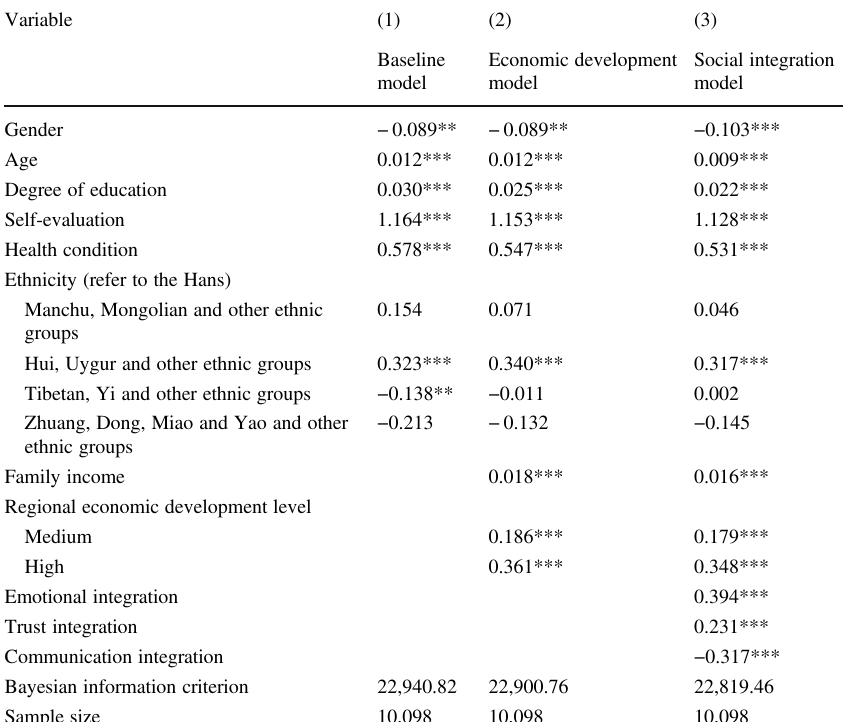
Table 4 Model analysis of economic development, social integration and the happiness of ethnic groups